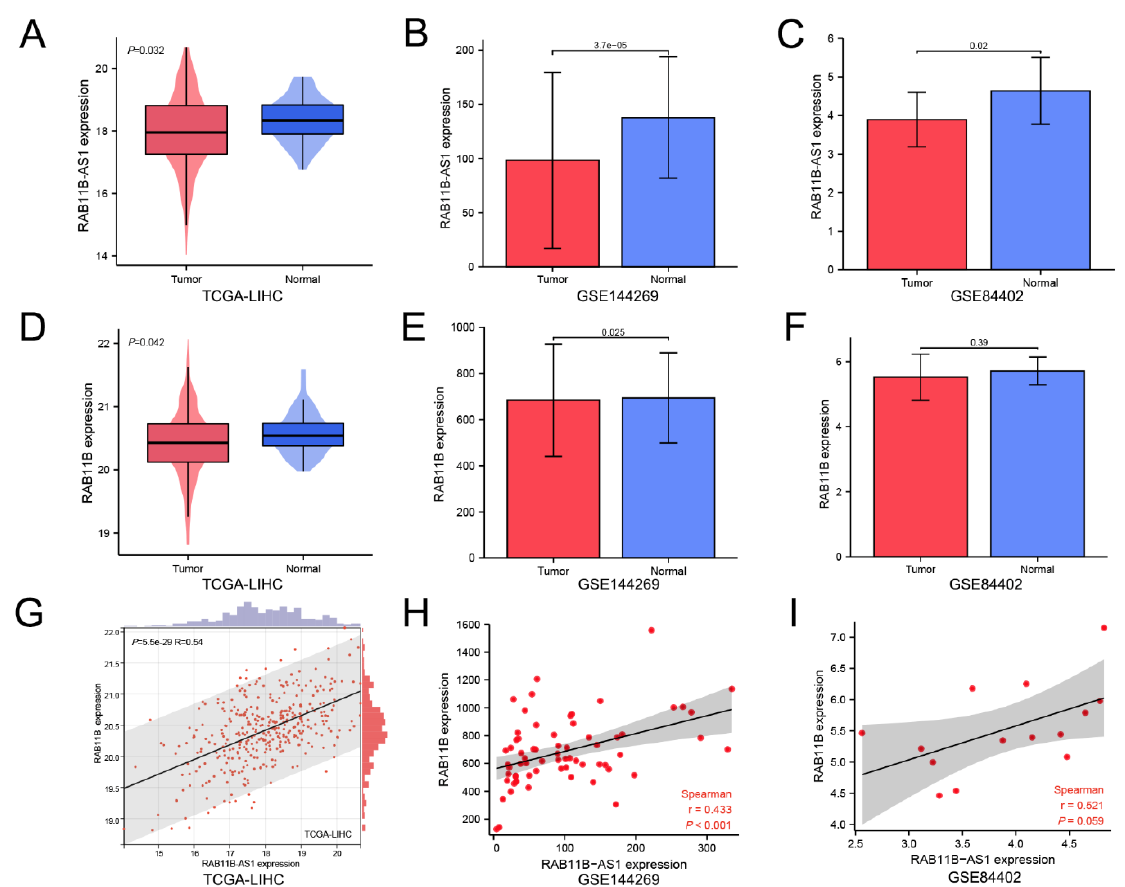
Figure 1. Comparison of lnc-RAB11B-AS1 and RAB11B expression in HCC and normal liver tissues